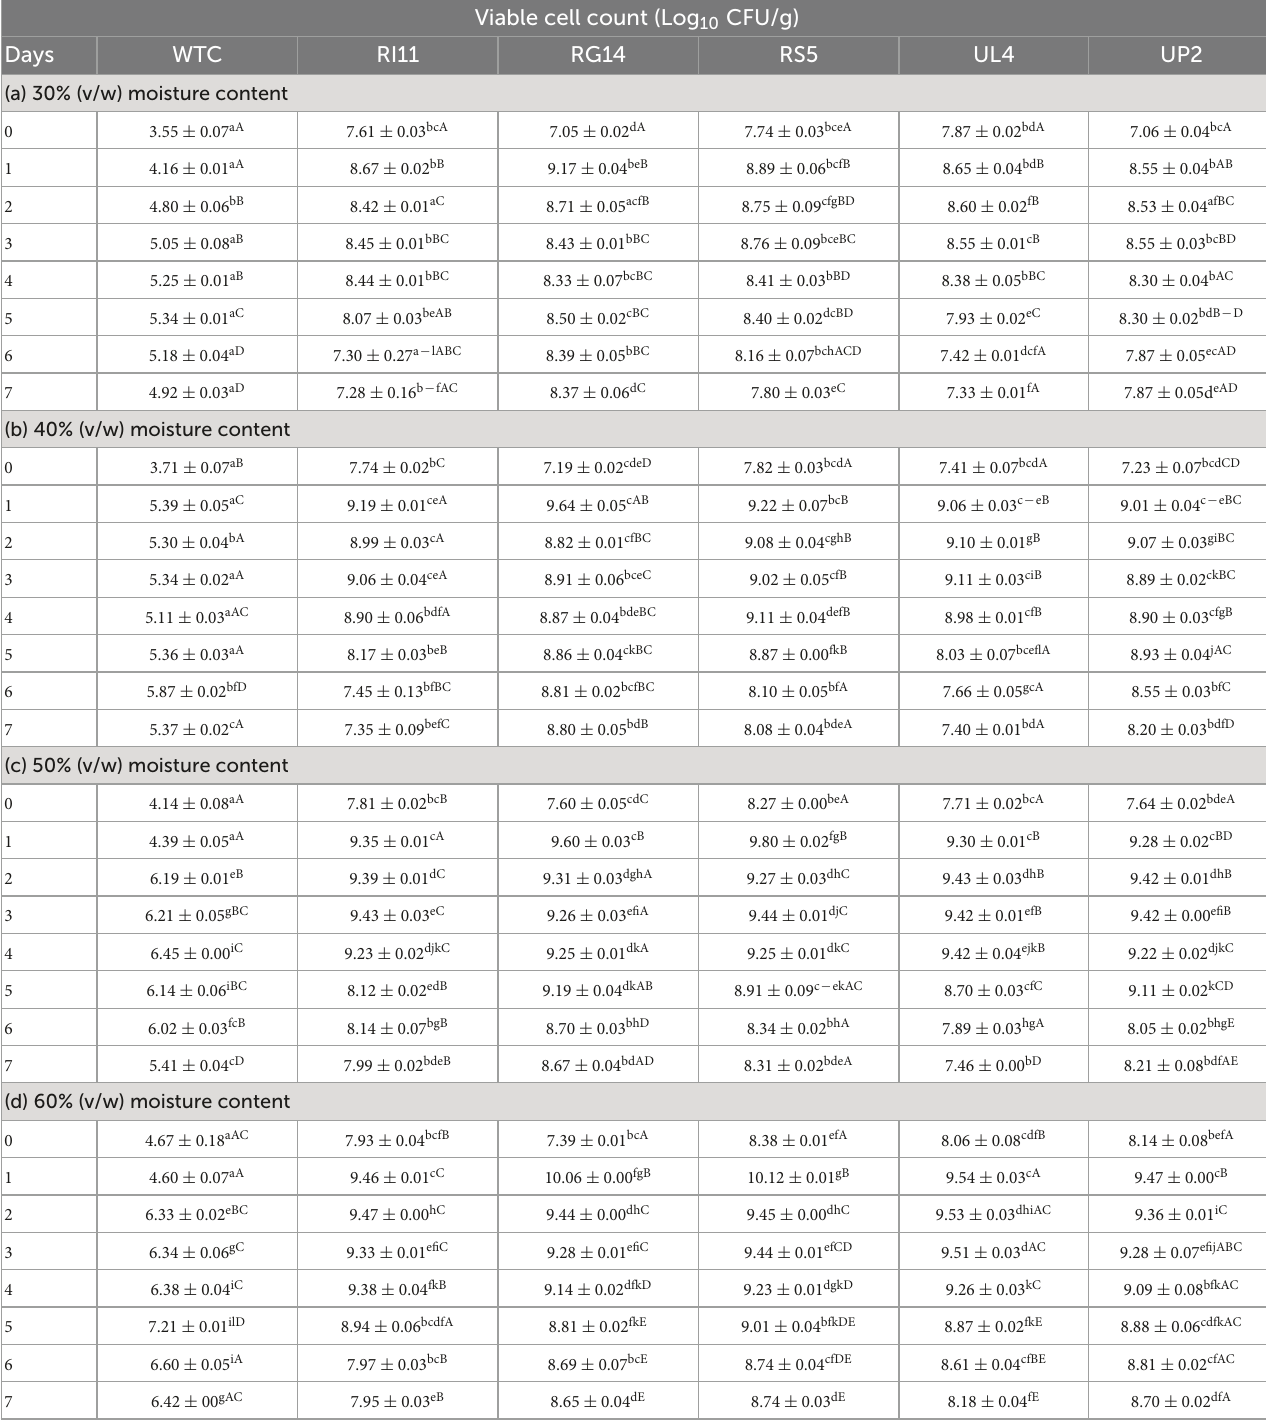
TABLE 1 Effect of moisture contents on the cell viability of probiotic LAB strains during solid-state fermentation of composite flour for 7